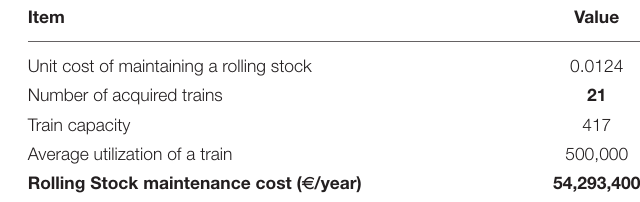
TABLE 15 | The rolling stock maintenance cost ( e /year).